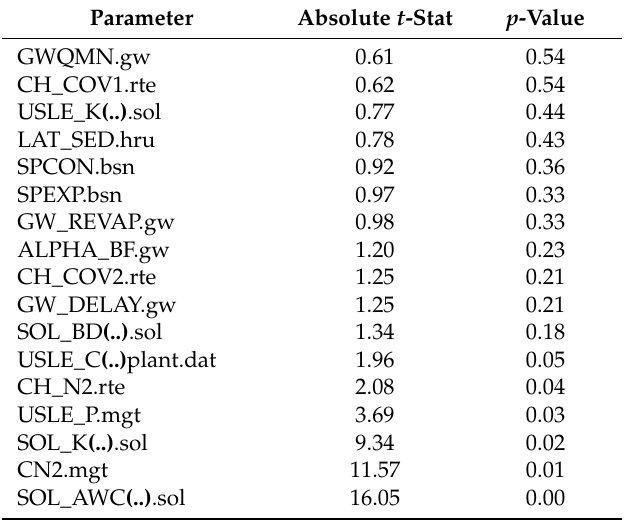
Table 4. Effective parameters arranged from low to high sensitivity based on t -stat and p